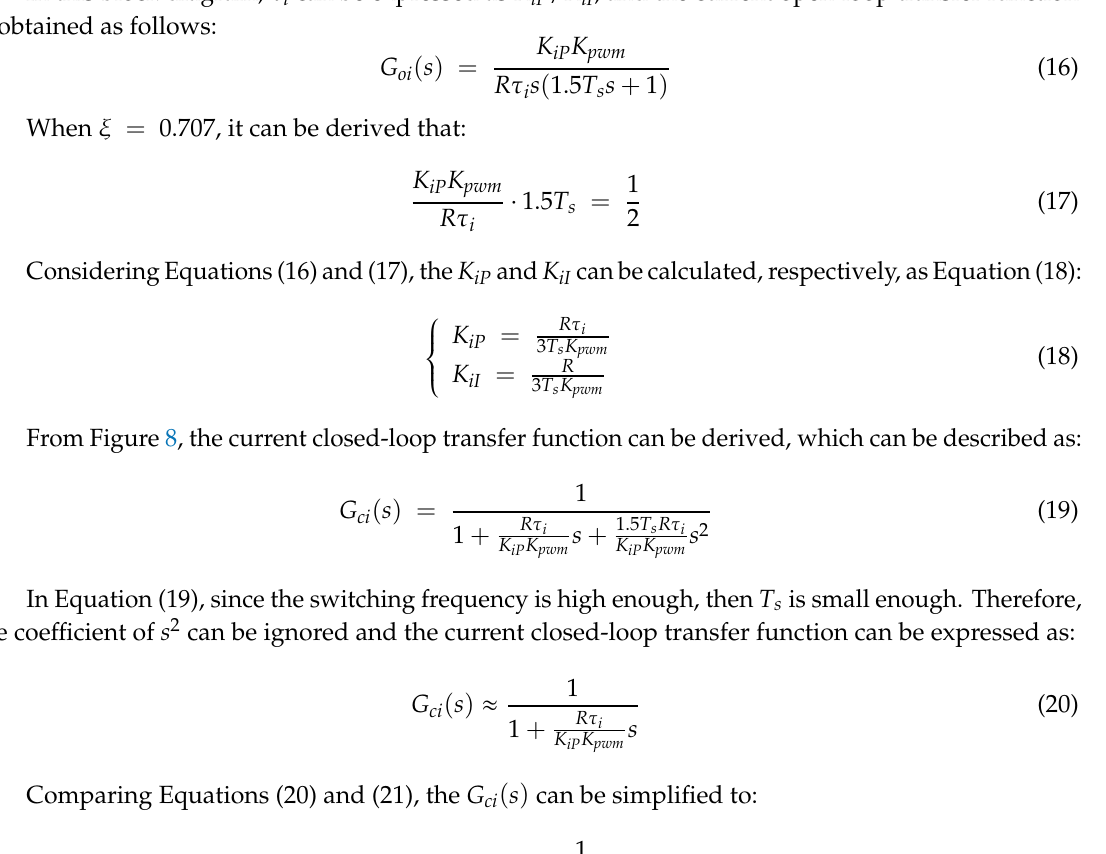
Table 1. Related parameters of the